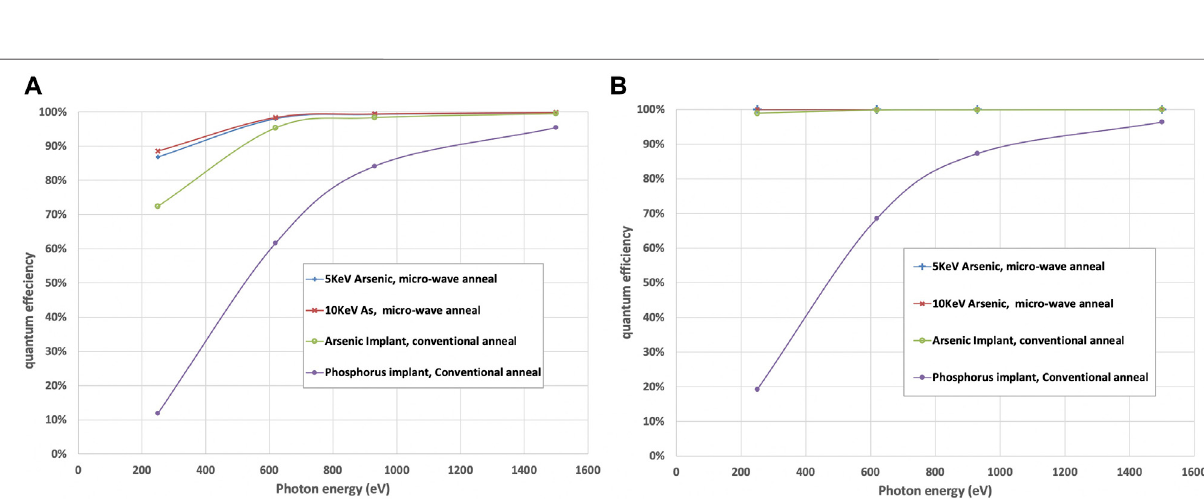
Frontiers in Physics |